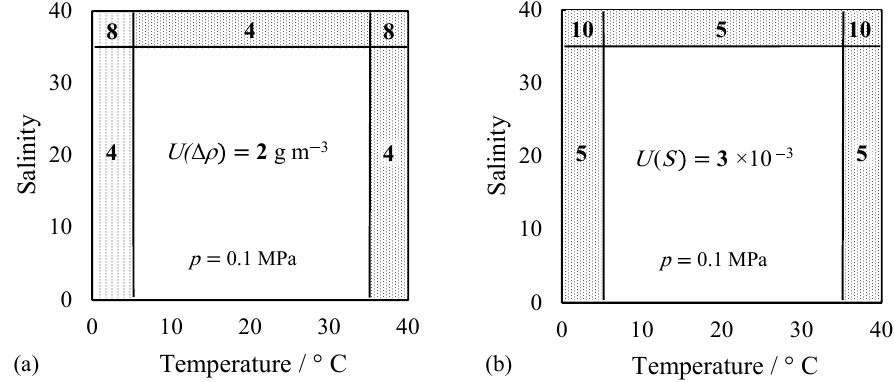
Figure 6. Uncertainty in the density–salinity relation at 101325Pa. (a) Uncertainty in the relative density of air-saturated seawater, U((cid:49)ρ SW ) , that results from a calculation using salinity and temperature values. (b) Uncertainty in salinity, U(S) , that results from an inverse calculation using the relative density of air-saturated seawater and temperature values. The white area indicates the measurement region equal to that of the data set used for fitting. The grey area indicates the extrapolation region.